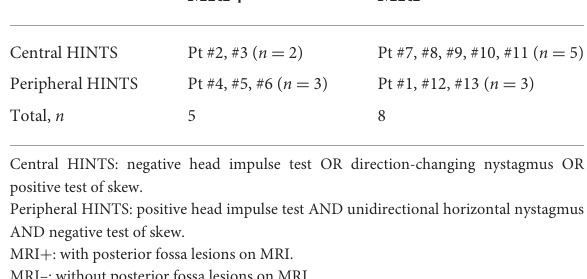
TABLE 2 The distribution of the 13 patients in HINTS battery and MRI findings. MRI + MRI– Central